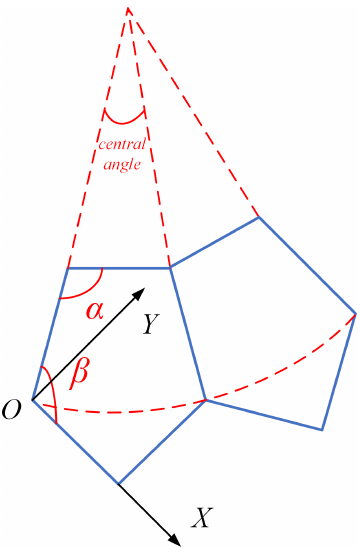
Figure 5. The top view of the closed-ring deployable mechanism